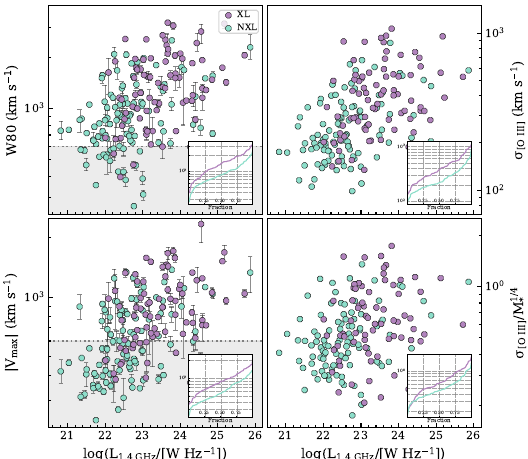
Figure 10. Same as Figure 7, but X-axes show radio luminosity. The purple and green circles exhibit the XL and NXL AGNs, respectively. The dotted lines and shaded regions indicate weak ionized outflows. In each panel, the inset plot compares the cumulative fraction between the RL and NRL AGNs.